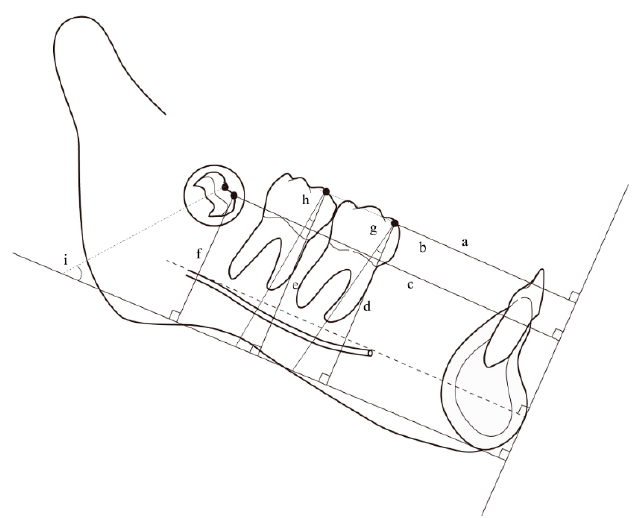
Figure 4. Schematic illustration of the measurements. (a–c) Distance between the MB cusp of each tooth and the frontal plane; (d–f) distance between the MB cusp of each tooth and the horizontal plane; (g–i) angulation of each tooth to the horizontal plane. The first and second molar axis were defined as extending through the MB cusp and apex of the mesial root. The third molar axis was defined and extended through the midpoint of the crown and the mesial and distal endpoint of the developing